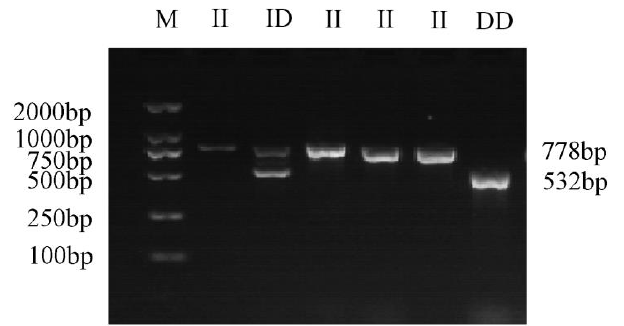
Figure 1. The gel electrophoresis of different genotypes of GHR-SV246; M, GL DNA marker 2000; II, homozygous insertion type; ID, heterozygous type; DD, homozygous deletion type.